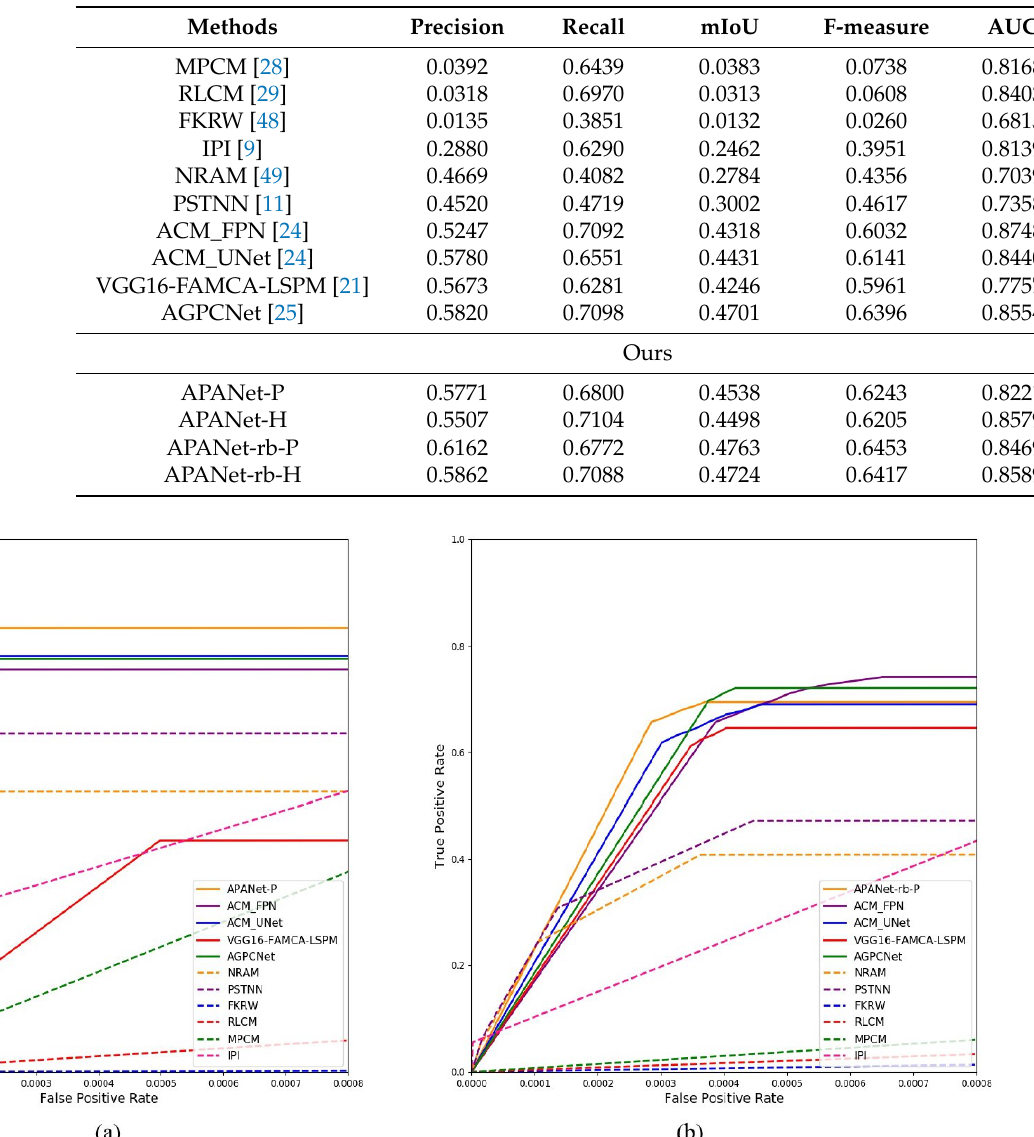
Table 4. Comparison with different detection methods on MDFA dataset.